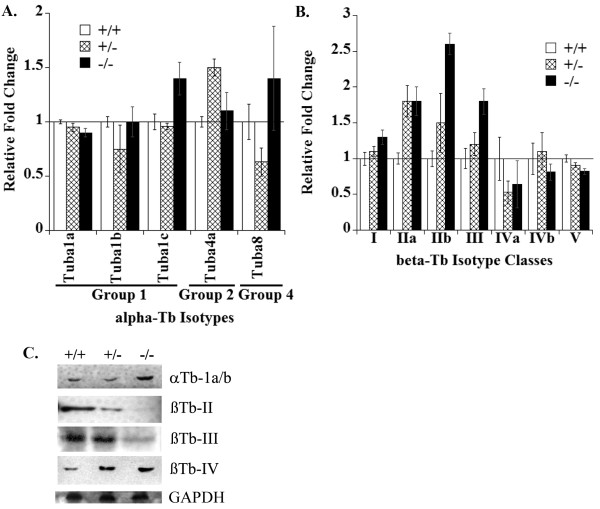
Tubulin isotypes are differentially regulated with STMN1 knock-out. Tubulin isotypes for α- and β-tubulin mRNAs were measured by qRT-PCR (Methods). (A) α-tubulins and (B) β-tubulins. (C) Protein levels were measure by immunoblots of whole cell lysates from each genotype, loading control is GAPDH.